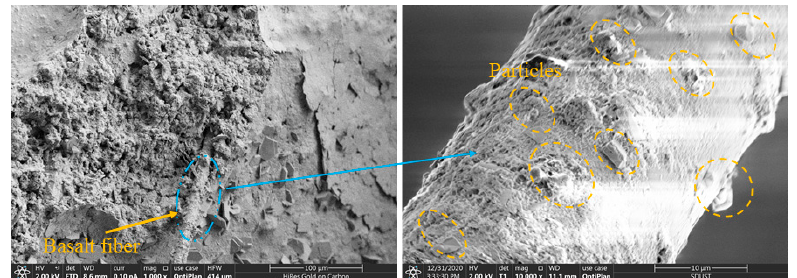
Figure 9. SEM image of thermal-insulation concrete with 5%